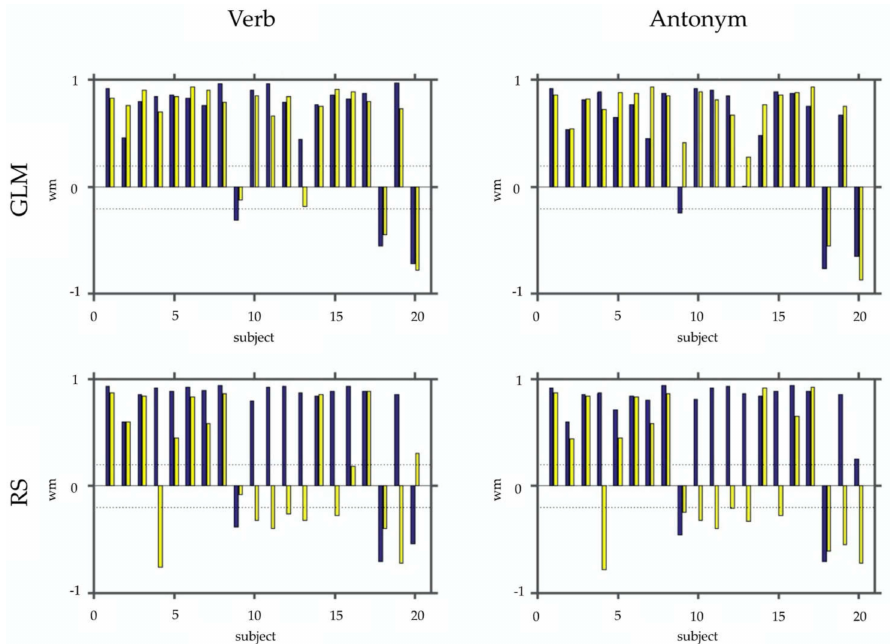
Figure 3. This figure depicts the WMLI on a single subject basis. In the upper row, panels show the results of the SPM contrasts (GLM) for the verb and antonym generation. In the bottom row, the same is shown for the selected RS-fMRI components (RS). Each panel shows bar plots with the WMLI results using a control condition (blue) vs. not using one (yellow). For better interpretation of the WLMI results, we added two dashed lines representing the interval [ − 0.2;